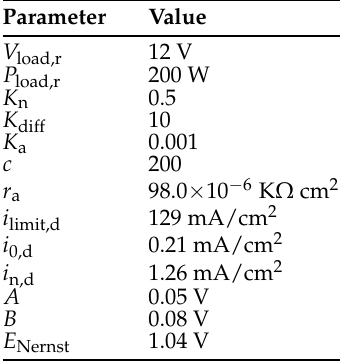
Table 7. PEMFC parameters and